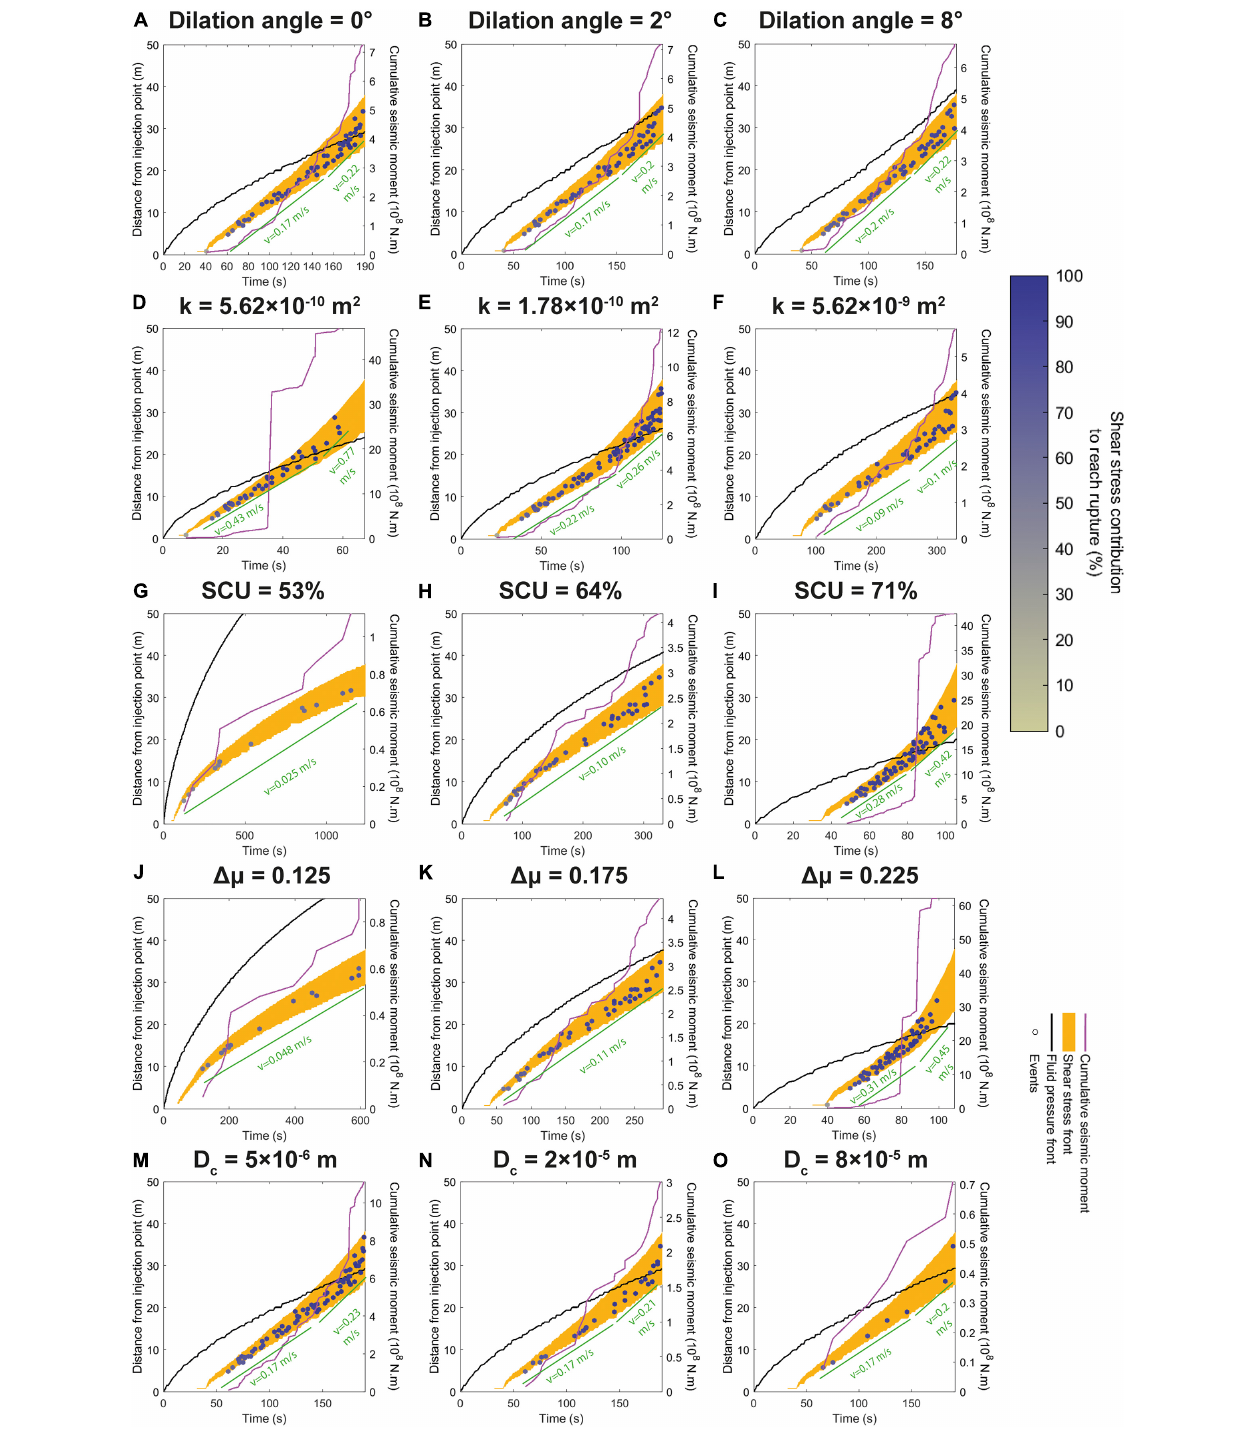
FIGURE 5 | Distance between seismic events and injection point as a function of their time of occurrence for various dilation angles ( A: 0 ◦ ; B: 2 ◦ ; C: 8 ◦ ), initial permeabilities ( D: 5.6 × 10 − 10 m 2 ; E: 1.8 × 10 − 9 m 2 ; F: 5.6 × 10 − 9 m 2 ), stress criticalities ( G: 53%; H: 64%; I: 71%), friction drops ( J: 0.125; K: 0.175; L: 0.225) and critical slip distances ( M: 5 × 10 − 6 m; N: 2 × 10 − 5 m; O: 8 × 10 − 5 m). The seismic events are represented by disks whose color is function of the shear stress transfer contribution (SSC) to reach rupture for each event. The cumulative seismic moment during the simulation is shown in magenta. The pressure front is defined as a black line, the shear stress front is represented in orange. The green straight line below seismicity indicates the mean migration velocity of seismic events. Note that time and moment scales differ among panels.